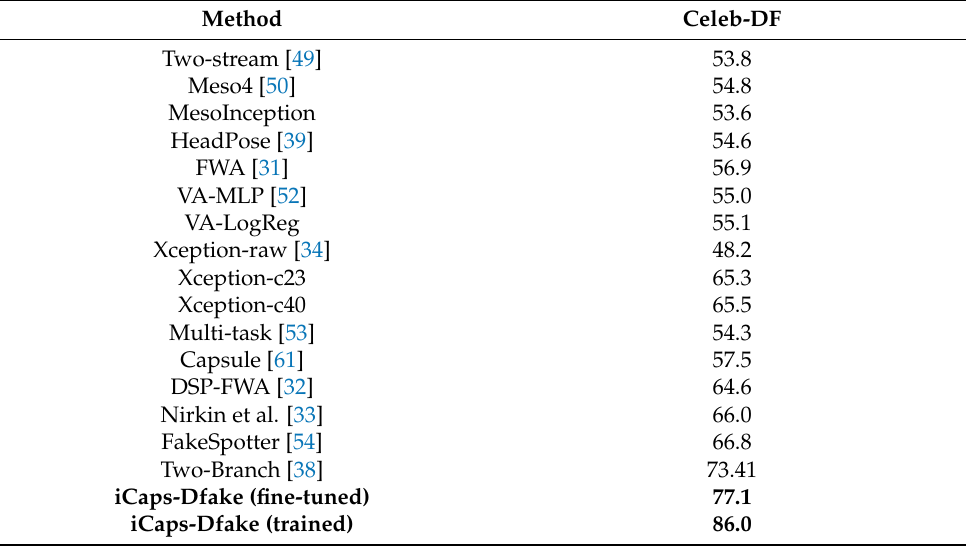
Table 4. Frame-level AUC scores (%) for the proposed iCaps-Dfake model compared to previous detection methods when tested by